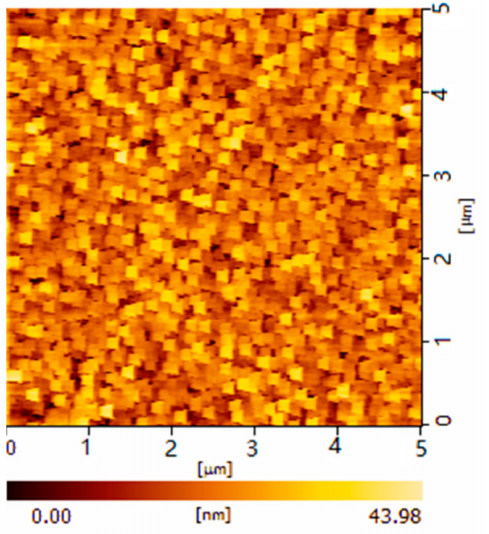
Figure 6. The AFM image of GaN NL before